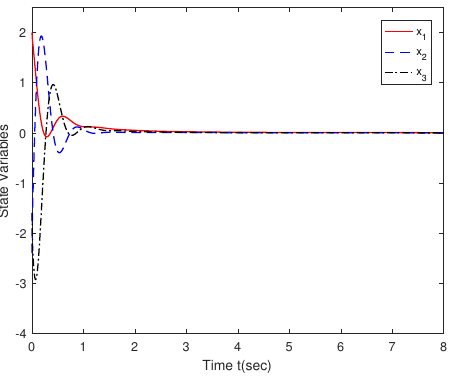
Figure 3. State responses of the normalization-based integral sliding mode control (SMC). Example